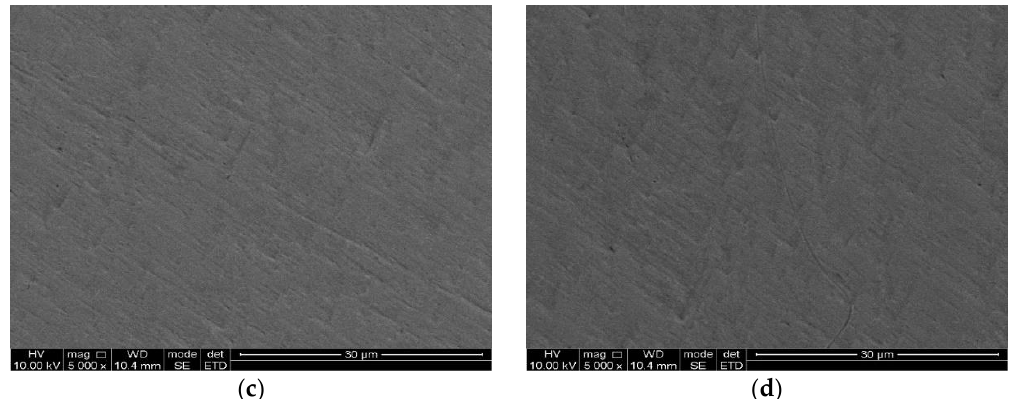
Figure 7. Scanning electron microphotograph results. ( a ) Surface morphology of the Ti–6Al–4V alloy immersed in SRB solution for 31 days, ( b ) surface morphology of the Ti–6Al–4V alloy immersed in SRB solution for 31 days without corrosion products, ( c ) untreated sample, and ( d ) surface of the Ti–6Al–4V alloy coupon exposed to sterile water for 31 days.